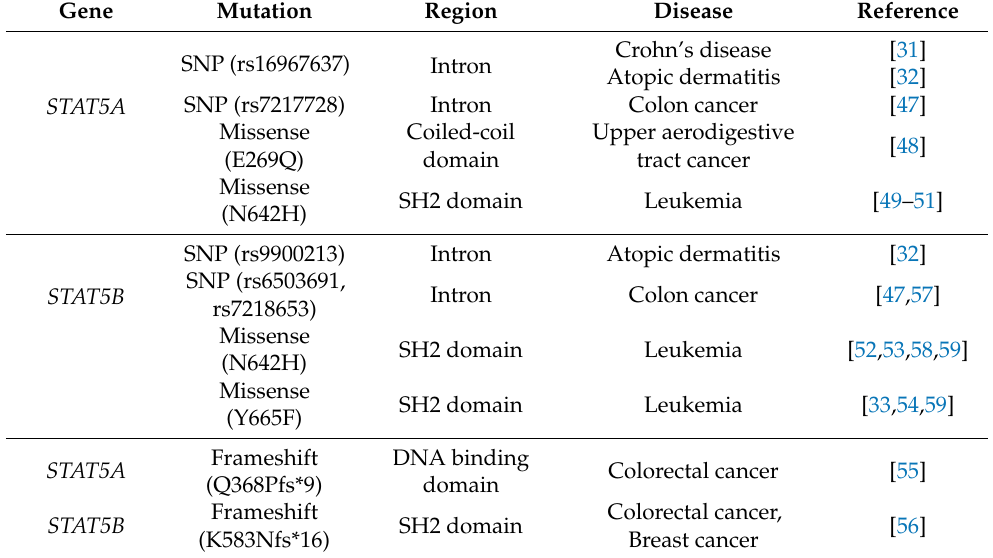
Table 2. Types of STAT5 genomic mutations associated with